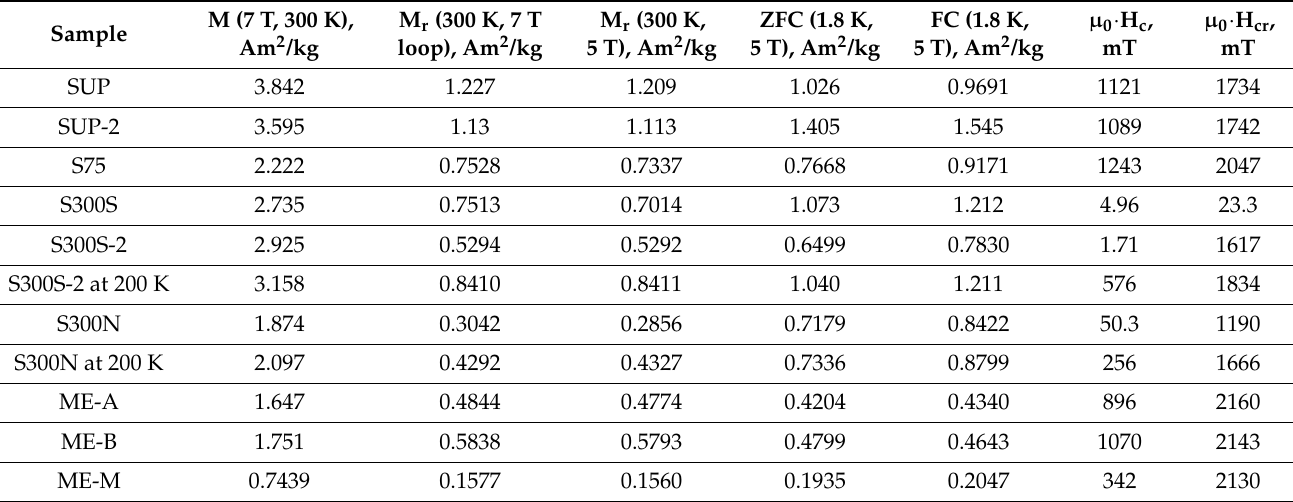
Table 4. Coercivity, magnetization, and remanence of synthesized samples.